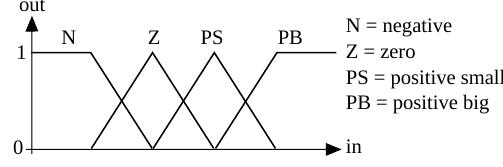
Figure 32. Typical membership